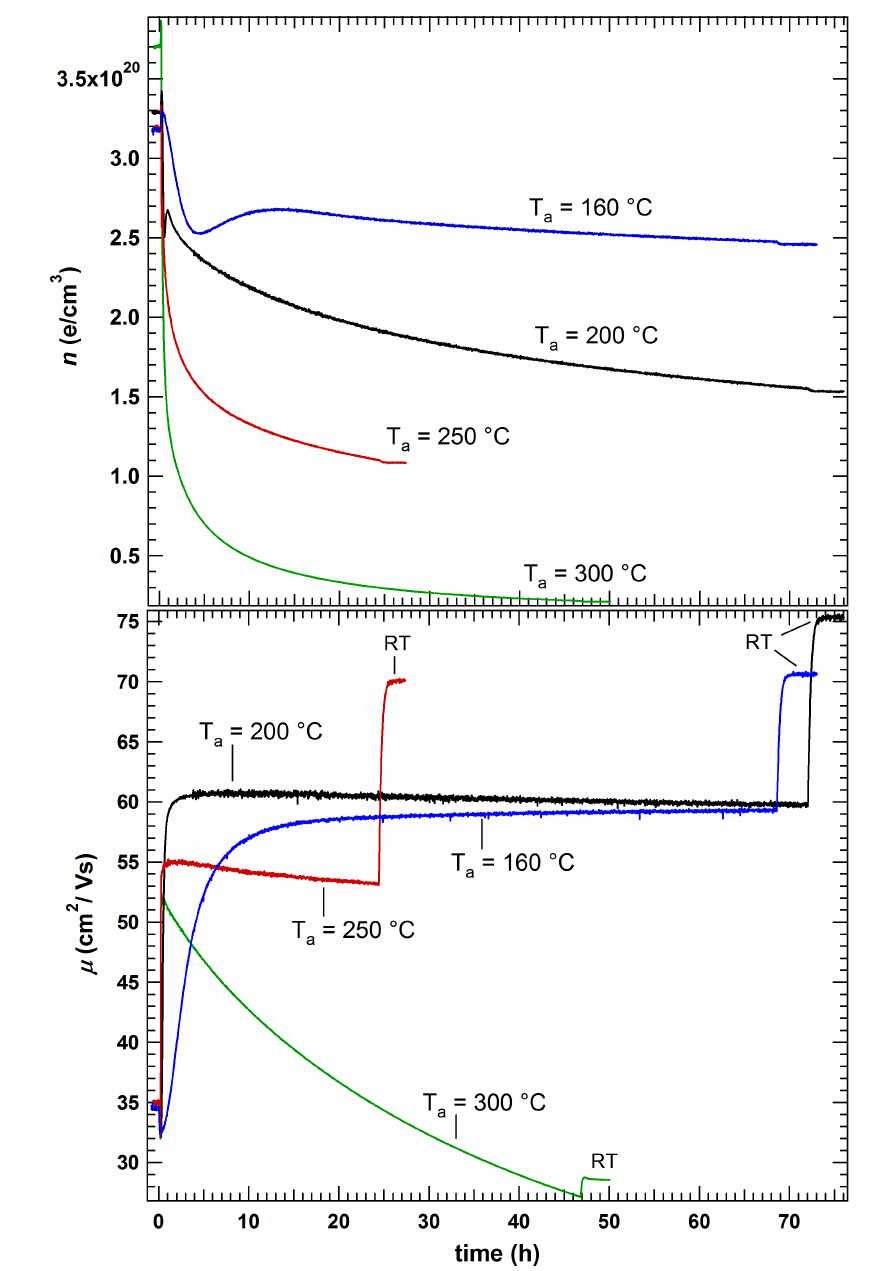
Figure 5. In situ Hall effect measurements during vacuum annealing at different temperatures of as-deposited films with p (H O) = 1 . 0 × 10 − 3 Pa. All samples originate 2 from the same deposition. The start of furnace heating is set to 0 h, with a rate of 20 K/min to reach the target